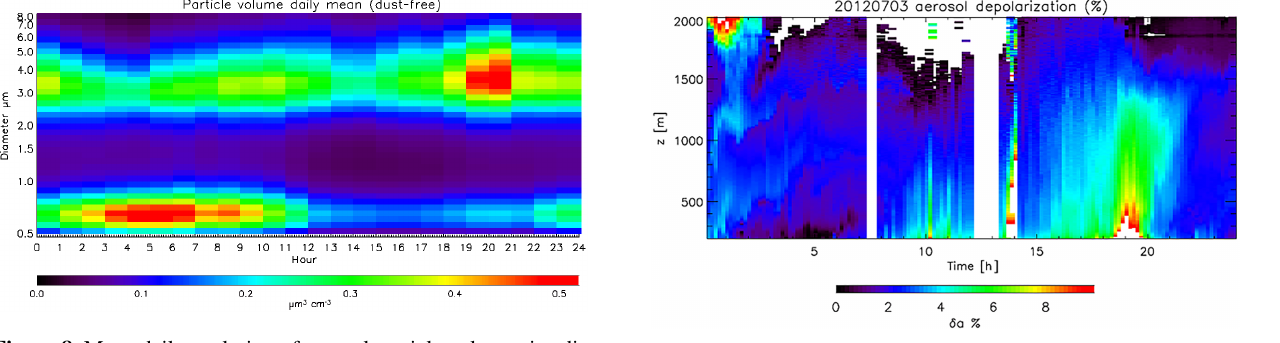
Figure 9. Vertical profiles of lidar aerosol linear depolarization ratio on 3 July